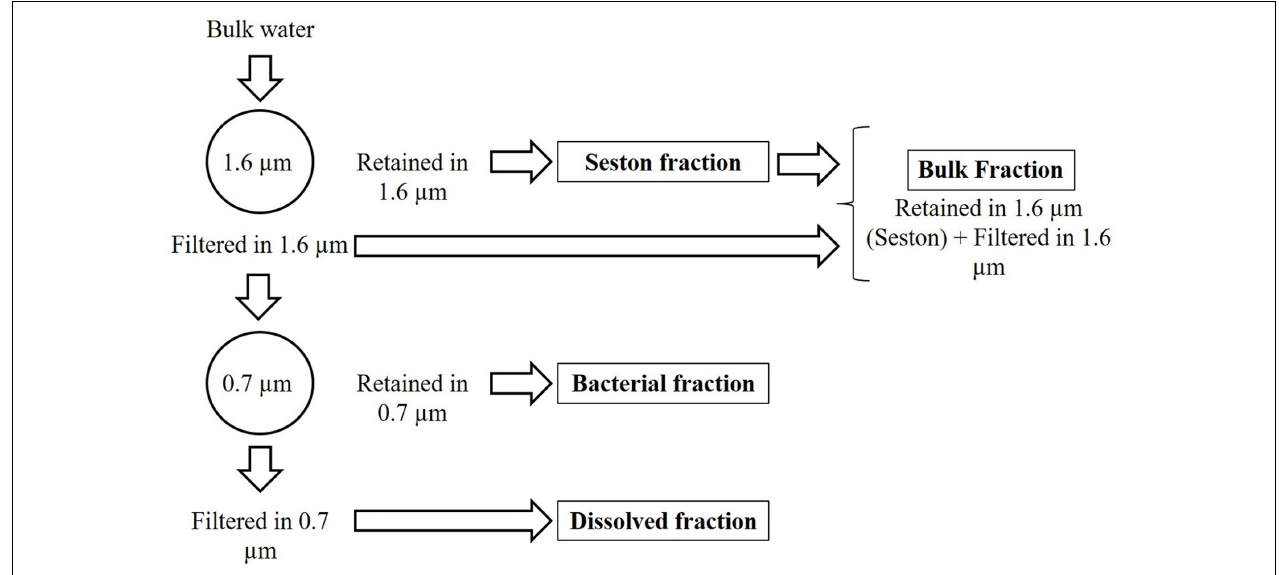
FIGURE 1 | Scheme of the size fractionation of the